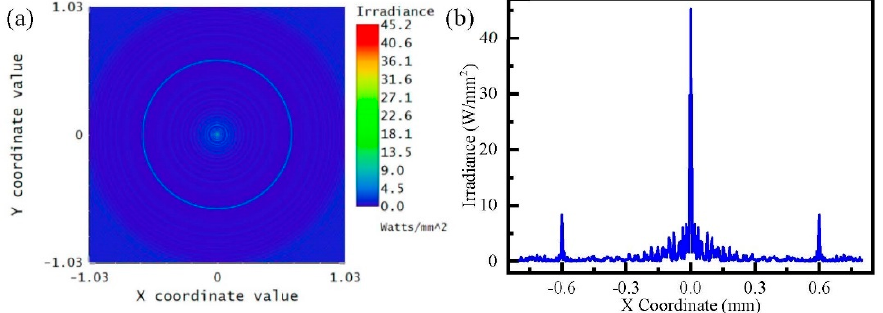
Figure 4. Simulation of annular Fresnel zone plate (AFZP) with 𝑅 as 0.6 mm and 𝑟 (cid:2868) as 80 μ m: ( a ) annular beam and central spot in focal plane; ( b ) energy distribution in the focal